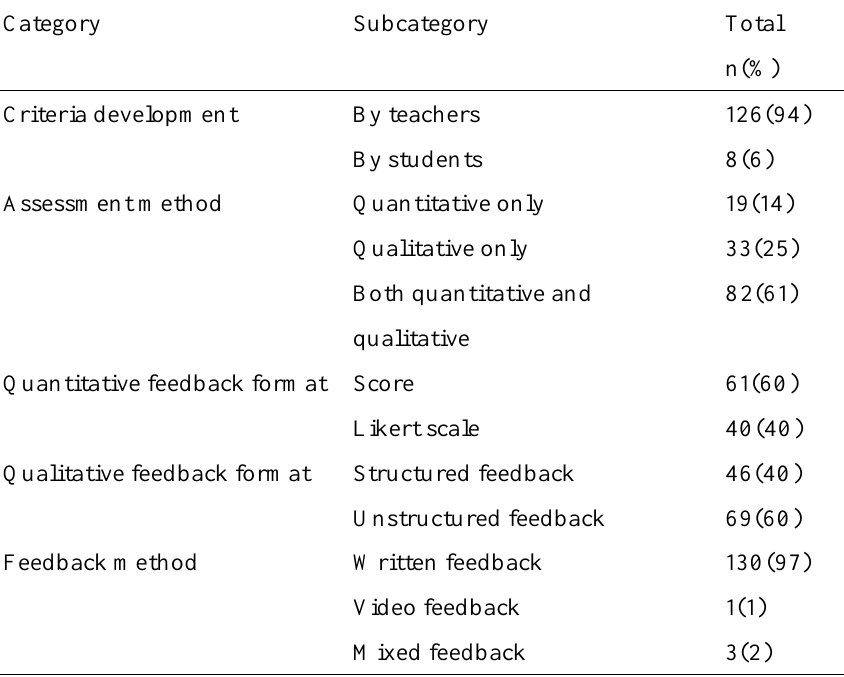
Descriptive Data for the Peer Assessment Criteria